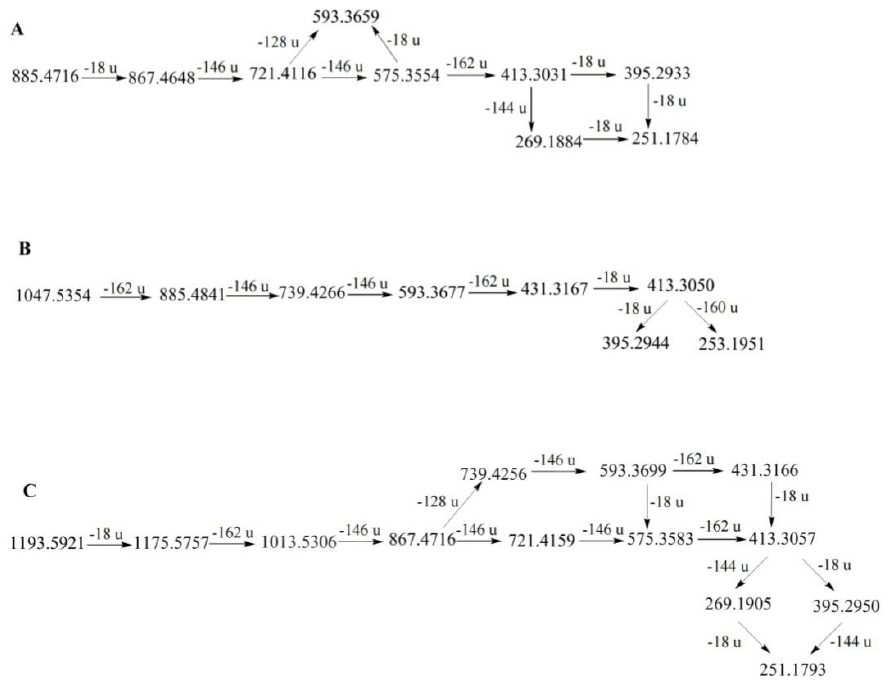
Figure 5. The flavonoid skeletons identified from different parts of PPL in positive ion mode. ( A ) Kaempferol-type; ( B ). quercetin-type; ( C ) luteolin-type; ( D ) isorhamnetin−type.